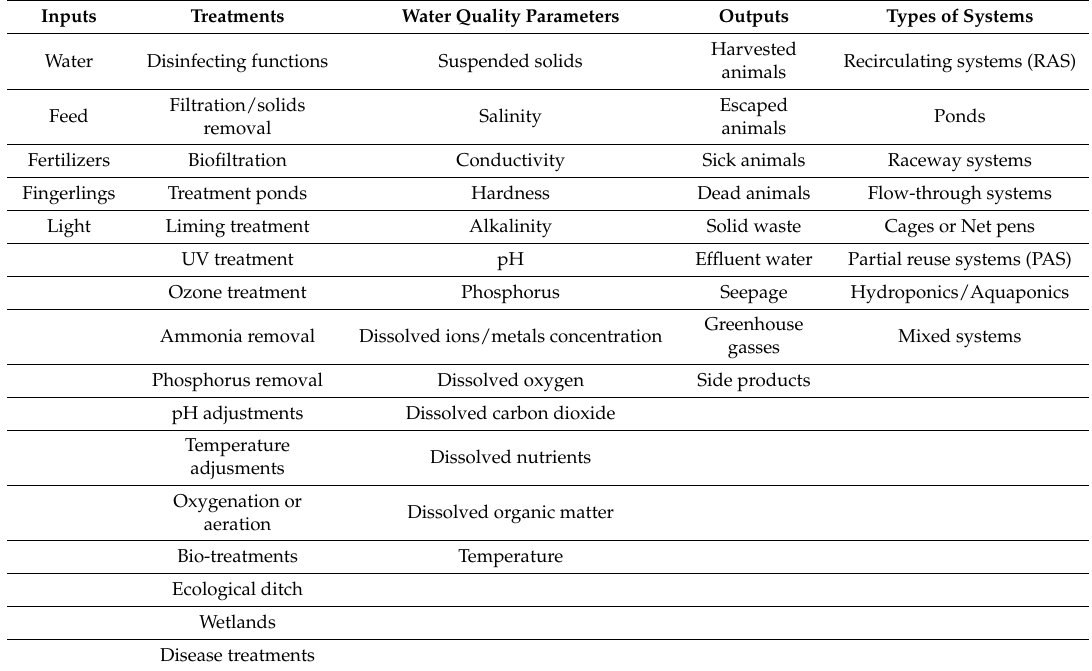
Table 1. A summary of the paper analysis grouped as system inputs, treatments for the production system, water quality parameters, system outputs, and types of production